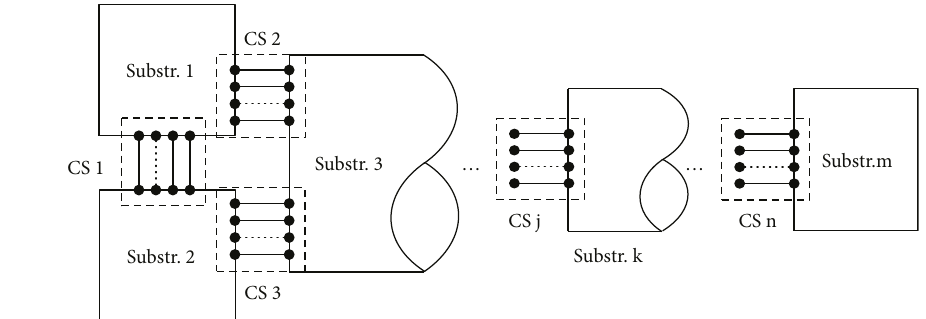
Figure 1: Substructure system with intricate